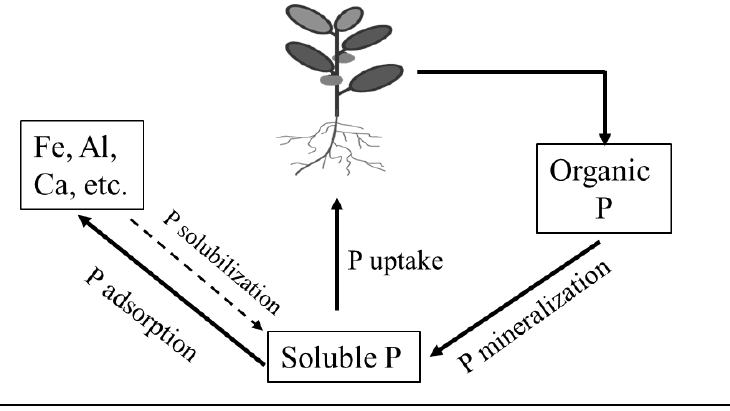
Figure 1. Schematic diagram showing the phosphorus circulation activity in soil.